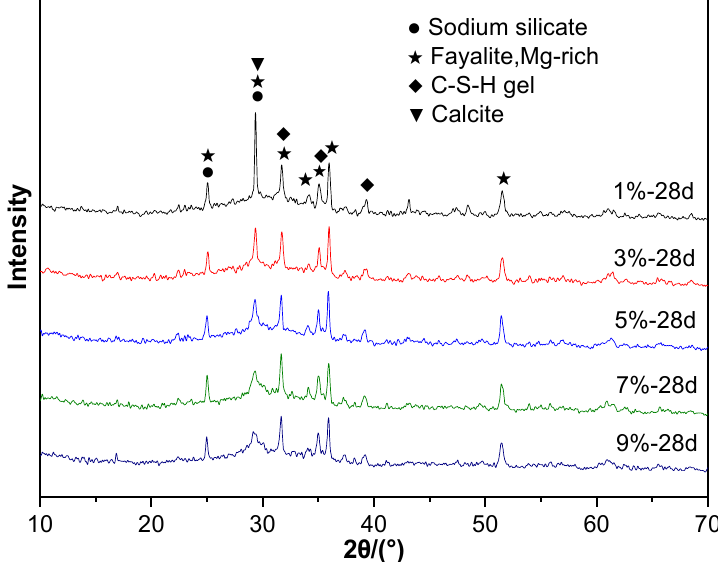
Figure 10. XRD patterns of alkali-activated CNS materials after hydration with different sodium silicate contents.